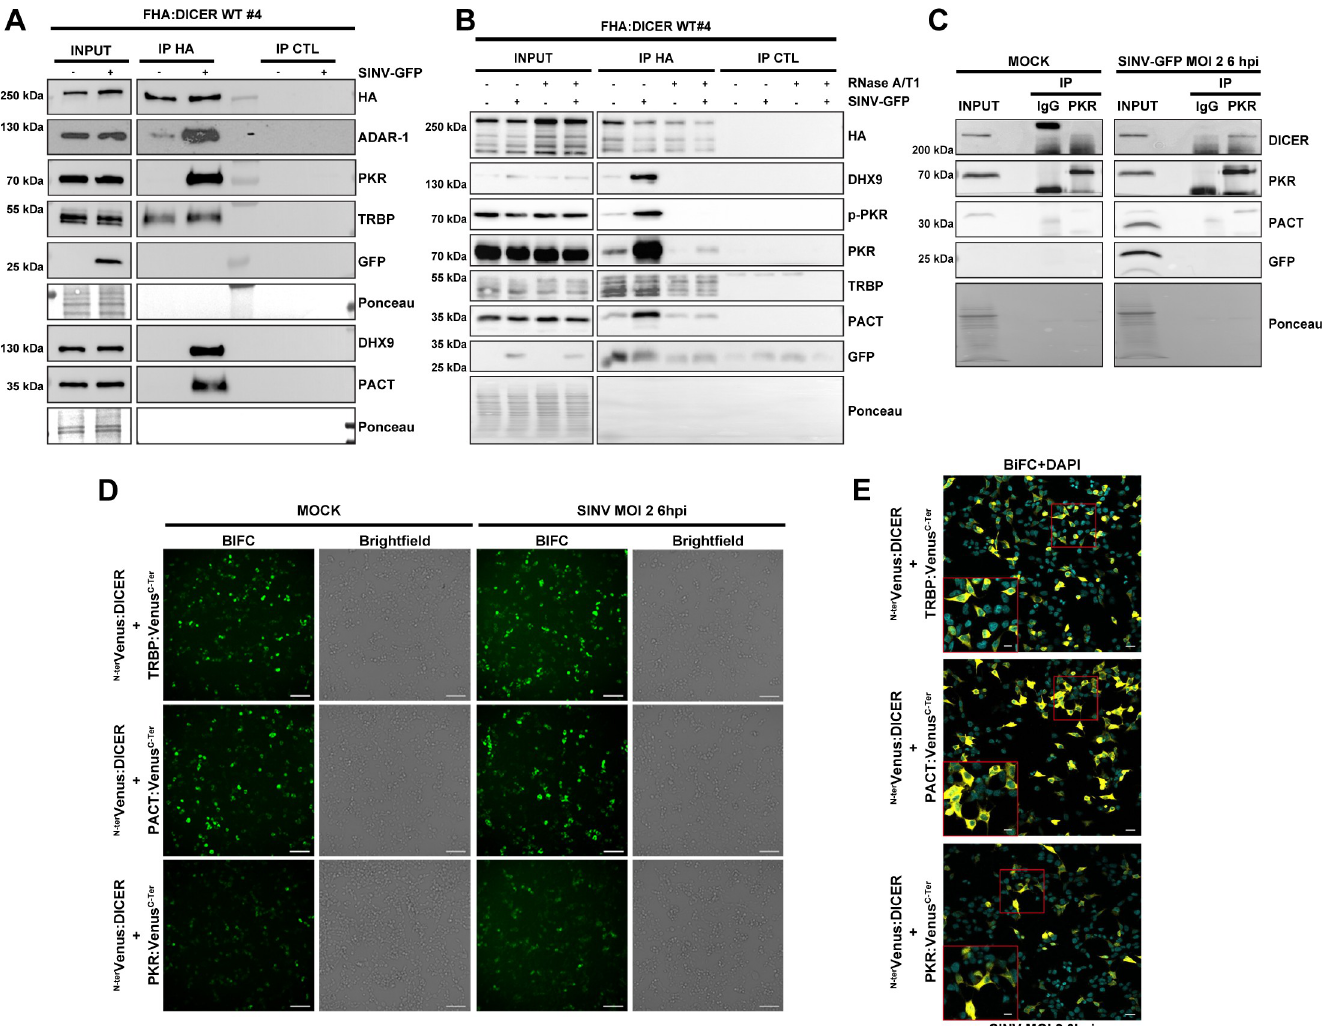
Fig 3. Confirmation of LC-MS/MS analysis by co-IP and BiFC. A. Western blot analysis of HA co-IP in mock or SINV-GFP-infected (MOI of 2, 6 hpi) FHA:DICER WT #4 cells. Proteins associated to FHA:DICER were revealed by using antibodies targeting endogenous ADAR-1, PKR, TRBP, DHX9 or PACT proteins. In parallel, an HA antibody was used to verify the IP efficiency and GFP antibody was used to verify the infection. Ponceau was used as loading control. B. Western blot analysis of HA co-IP in mock or SINV-GFP-infected (MOI of 2, 6 hpi) FHA:DICER WT #4 cells. The lysate was treated or not with RNase A/T1. Proteins associated to FHA: DICER were revealed by using antibodies targeting endogenous DHX9, p-PKR, PKR, TRBP, or PACT proteins. In parallel, an HA antibody was used to verify the IP efficiency and GFP antibody was used to verify the infection. Ponceau was used as loading control. C. Western blot analysis to validate the interaction of PKR with DICER (upper panel) and PACT (lower panel) in mock or SINV-GFP-infected HEK293T cells (MOI of 2, 6 hpi). Immunoprecipitated proteins obtained from PKR pulldowns were compared to rabbit IgG pulldowns to verify the specificity of the assay. D. Interactions between DICER and TRBP, PACT or PKR were visualized by BiFC. Plasmids expressing N-ter Venus:DICER and TRBP:, PACT: or PKR:Venus C-ter were co-transfected in NoDice Δ PKR cells for 24 h and cells were either infected with SINV at an MOI of 2 for 6 h or not. The different combinations are indicated on the left side. Reconstitution of Venus (BiFC) signal was observed under epifluorescence microscope. For each condition, the left panel corresponds to Venus signal and the right panel to the corresponding brightfield pictures. Scale bar: 100 μ m. hpi: hours post-infection. E. BiFC experiment on fixed NoDice Δ PKR cells treated as in D. After fixation, cells were stained with DAPI and observed under confocal microscope. Only a merge picture of BiFC and DAPI signals of SINV-infected cells is shown here. A higher magnification of picture showing cytoplasmic localization of the interaction represented by a red square is shown in the bottom left corner. Scale bars: 20 μ m and 10 μ m.